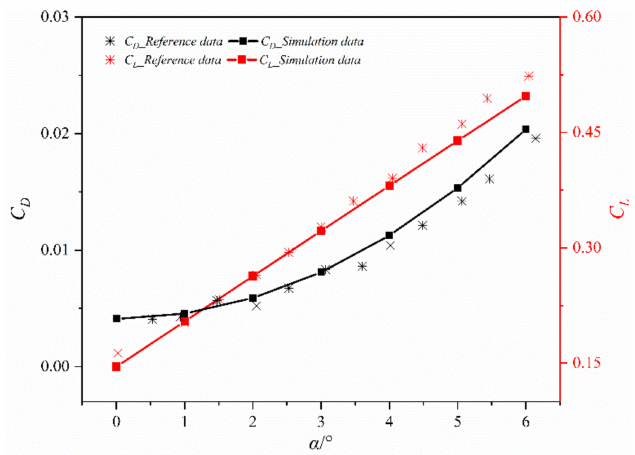
Figure 3. Method validation and comparison